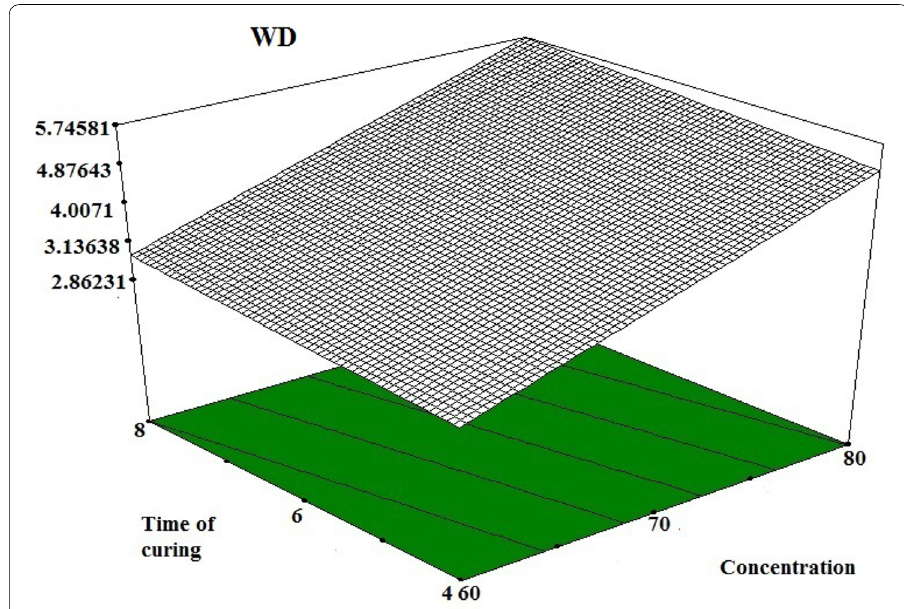
Fig. 6 Effect of process variables on WD of treated cotton. Time of curing &